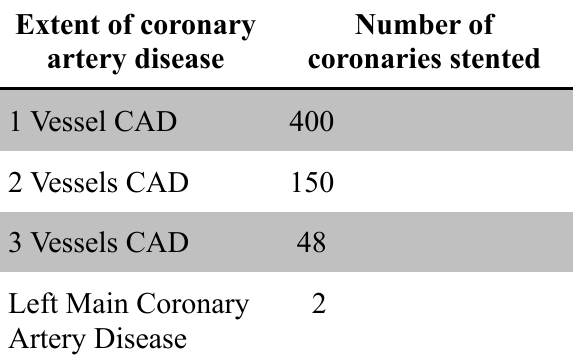
Table 1. Extent of Coronary Artery Disease (CAD) and number of coronaries stented